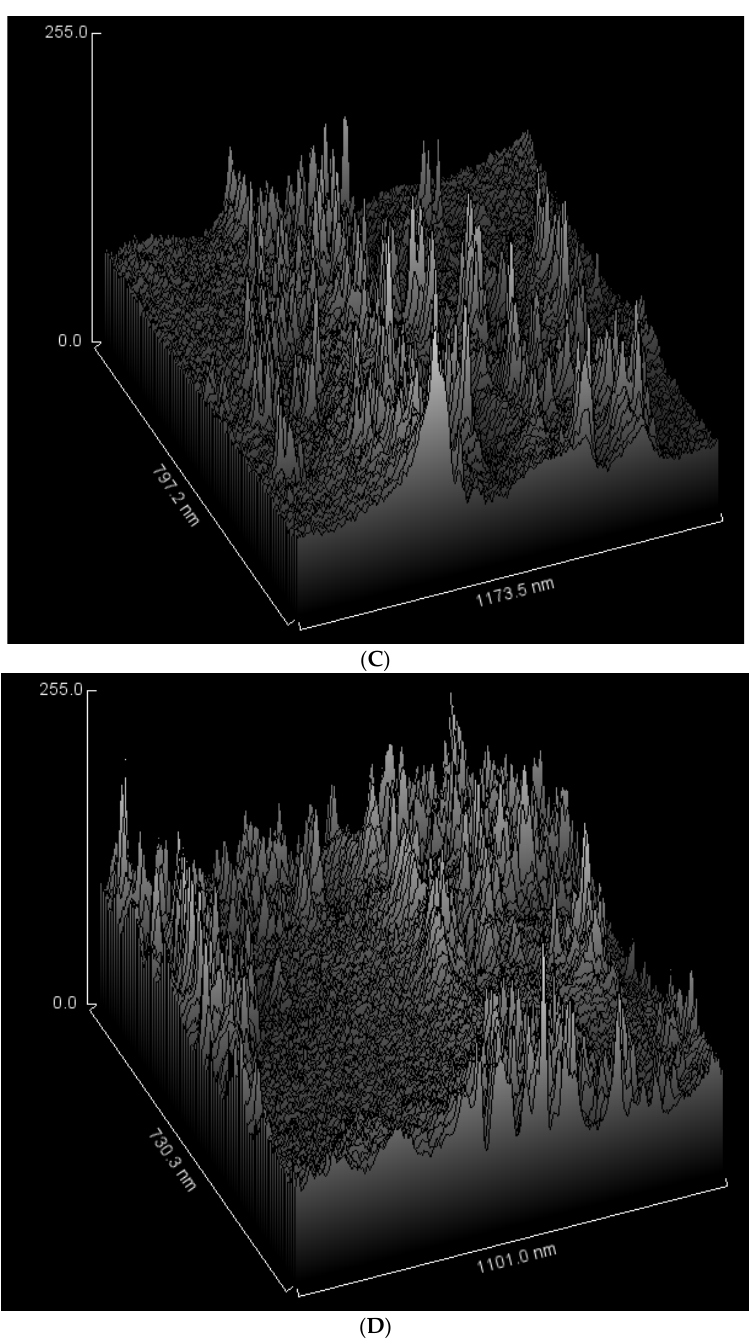
Figure 10. The surface roughness of the starch-based dressings as the citric acid content of the solution increases, ( A ) 0.46 wt% CA (SPGC1), ( B ) 0.92 wt% CA (SPGC2), ( C ) 1.38 wt% CA (SPGC3), ( D ) 1.83 wt% CA (SPGC4).